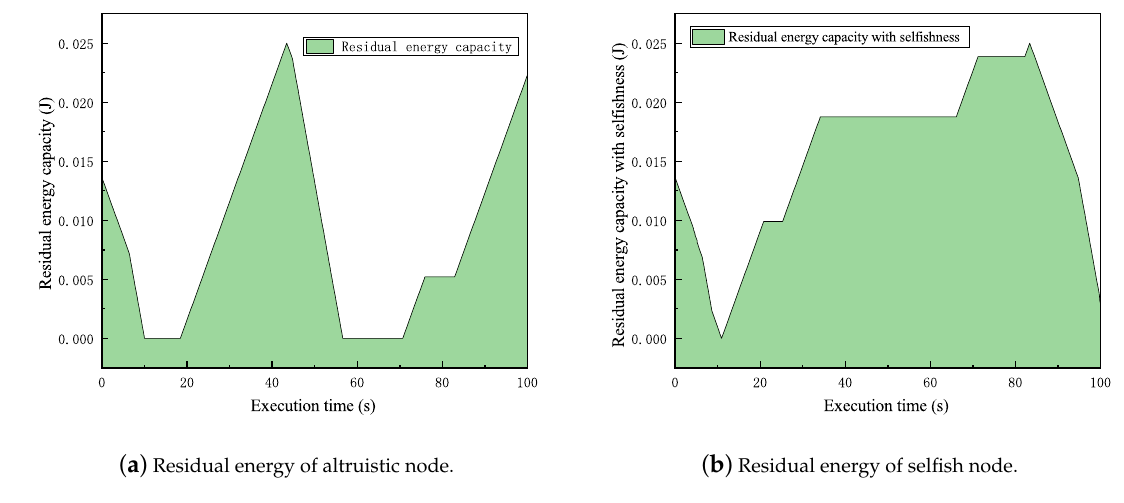
( b ) Residual energy of selfish node. Figure 4. Comparison of residual energy between altruistic and selfish nodes.